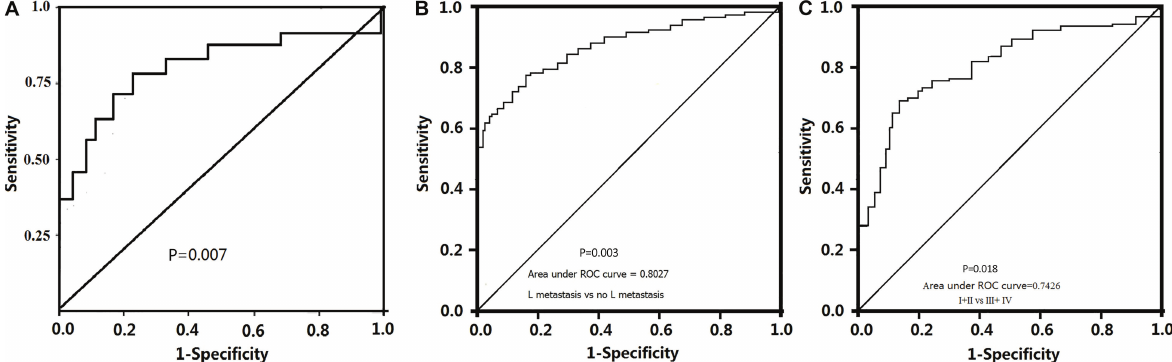
Figure 1. Receiver operating characteristic curve analysis of serum TGF- b 1 in pancreatic ductal adenocarcinoma patients vs benign pancreas disease ( A ), for lymph node metastasis vs non-lymph node metastasis ( B ), and for stage I + II vs stage III + IV ( C ).